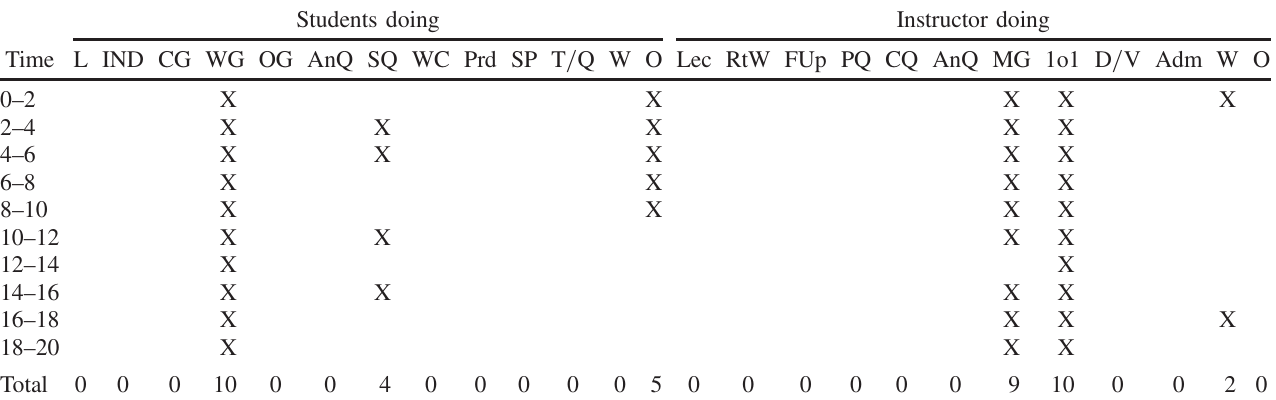
TABLE III. COPUS observation example. Time is measured in 2 min intervals.